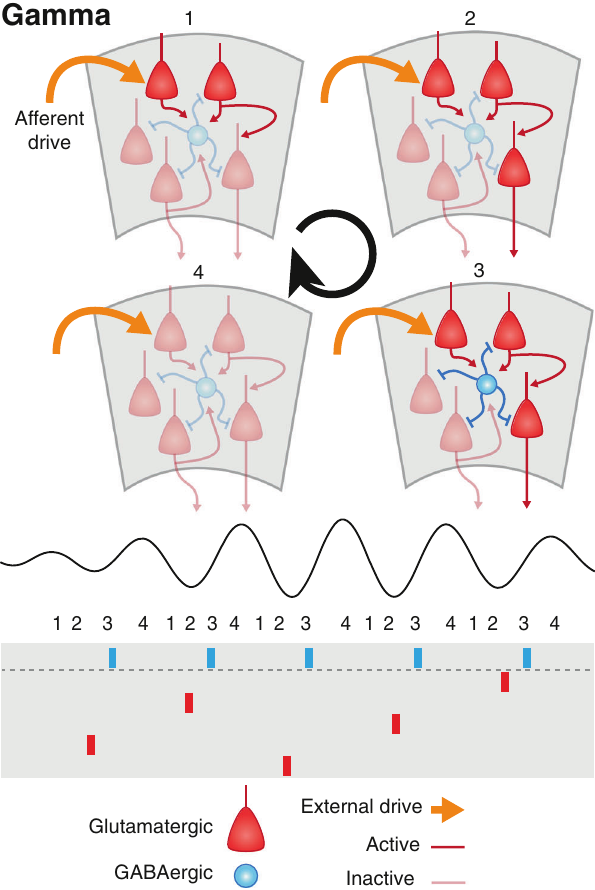
Fig. 3 Gamma oscillations are generated in both hippocampus and cortex through the reciprocal interaction between excitatory pyramidal cells and inhibitory interneurons. Top: Excitation arising from extrinsic afferents and intrinsic connections (stages 1 and 2) activates local interneurons (3), which temporarily silences the local network (4). Bottom: Interneurons ( blue rasters ) tend to fi re during every cycle of gamma, while pyramidal cells ( red rasters ) fi re sparsely only every few